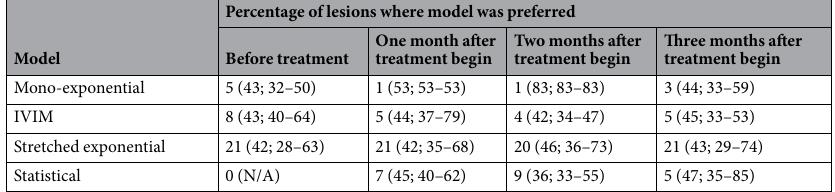
Table 5. Number of lesions at every time point where the respective diffusion models was preferred based on the majority of voxels. The values in parentheses are the median and range percentage of voxels where the respective model was preferred, considering only lesions where the tumour model was overall